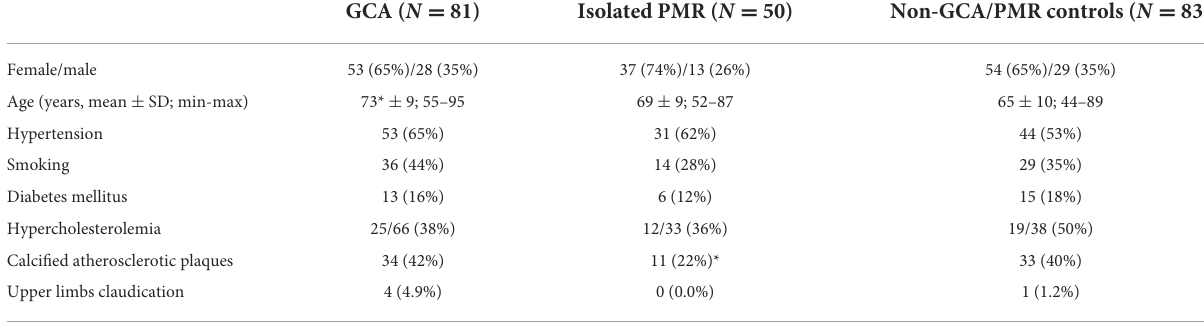
TABLE 2 The characteristics of